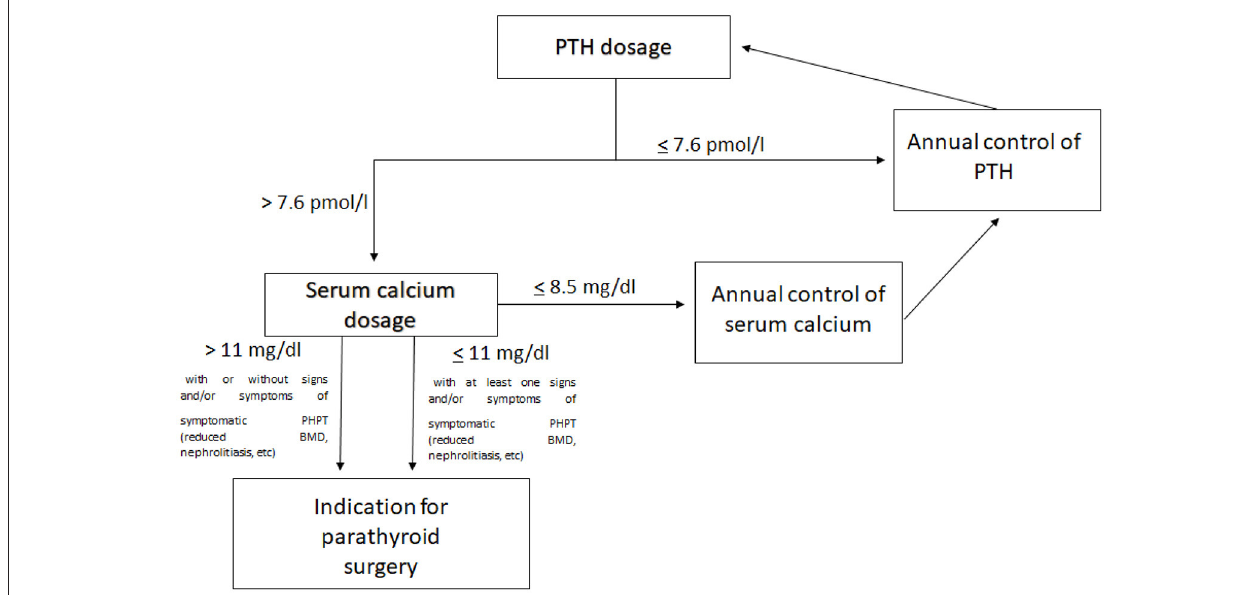
FIGURE 1 | Proposed PHPT workup in MEN1 patients.